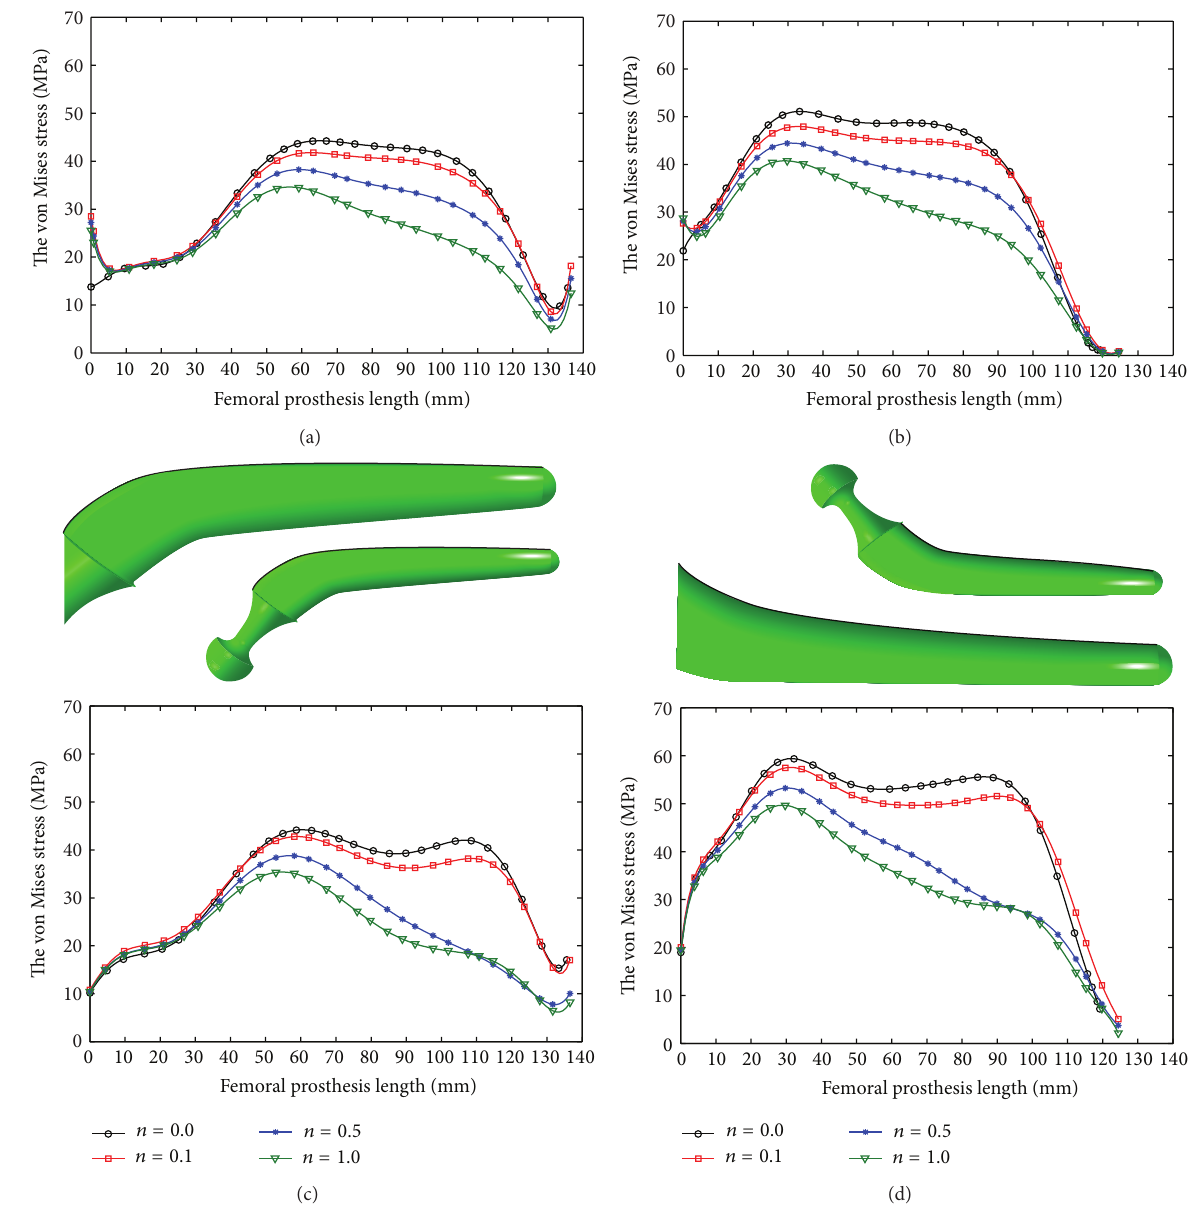
Figure 8: The von Mises stress variation on the longitudinal femoral prosthesis under stair climbing: (a) lateral side of cemented prosthesis, (b) medial side of cemented prosthesis, (c) lateral side of cementless prosthesis, and (d) medial side of cementless